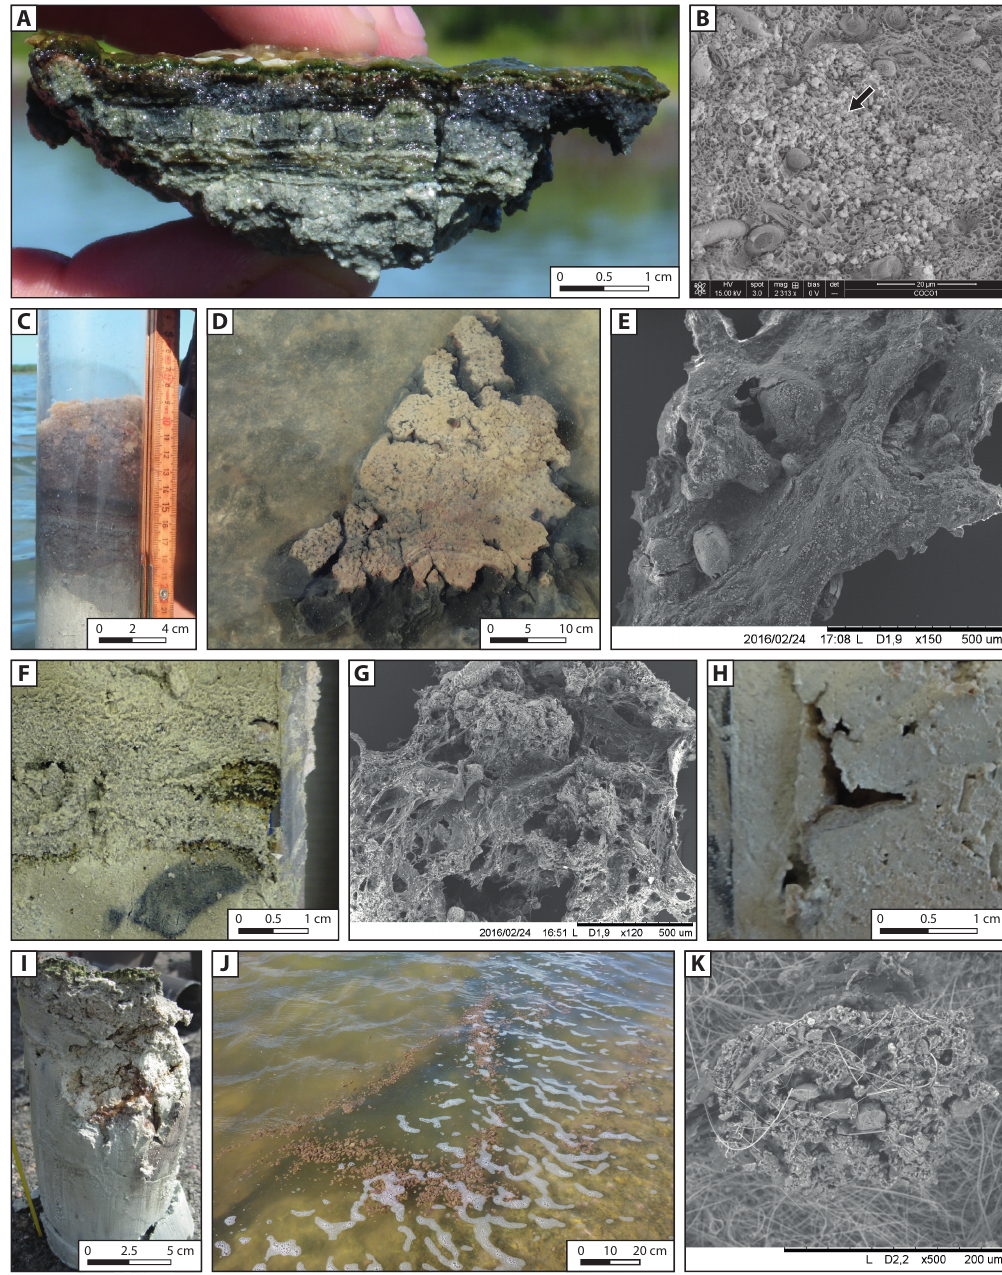
Figure 4. ( A ) The mineralising microbial mat. The active microbial mat is on the surface. Below, green layers, interpreted as fossil microbial mats are preserved within the sediments and interbedded with micritic (light grey) layers. ( B ) Cryo-SEM image of the mineralising microbial mat. Calcium carbonate minerals have precipitated within the EPS (black arrow) matrix surrounding filamentous cyanobacteria. ( C ) Slime layers collected from the bottom of the lagoon. ( D ) Raft of slime layers removed from the bottom of the lagoon by hydrodynamics and washed away along the shore of the lagoon. ( E ) SEM image of the slime. The EPS network retracted as the consequence of drying out. ( F ) Zoom on remnants of microbial mats embedded within the micritic muds of Core CC-2. ( G ) SEM image of the remnants of microbial mats. ( H ) Zoom on the microbial biofilm observed in a void in Core CC-1. ( I ) Photograph of a similar biofilm formed in a cavity. ( J ) Flowing fragments of slime removed from the bottom of the lagoon by wind and contributing to SPM. ( K ) SEM image of a SPM particle onto a GF / C